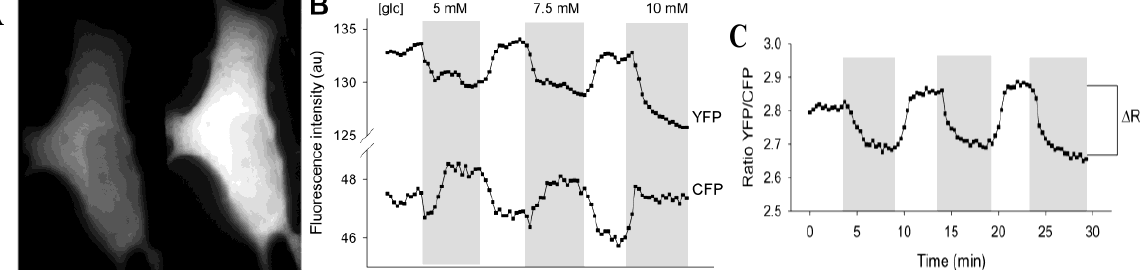
Figure 1. The extracellular glucose concentration modulates the fluorescence in 3T3-L1 cells expressing FLIPglu-600µ. ( A ) Photomicrographs showing fluorescence in a 3T3-L1 cell transiently expressing FLIPglu-600µ incubated without glucose. Using a dual view image splitter, the fluorescence of both fluorophores were separated and acquired simultaneously: cyan fluorescence (left panel, CFP) and yellow fluorescence (right panel, YFP); ( B ) Changes in the fluorescence intensity of YFP and CFP (recorded separately) in a single cell when incubated with different glucose concentrations (gray area) separated by 5-min incubations without glucose; ( C ) The YFP/CYP fluorescence intensity ratio was calculated from the data in ( B ). Δ R indicates the delta ratio, which is the difference between the average ratios obtained when the cells were incubated with and without glucose. The delta ratio is a measure of the change in the cytosolic glucose concentration.